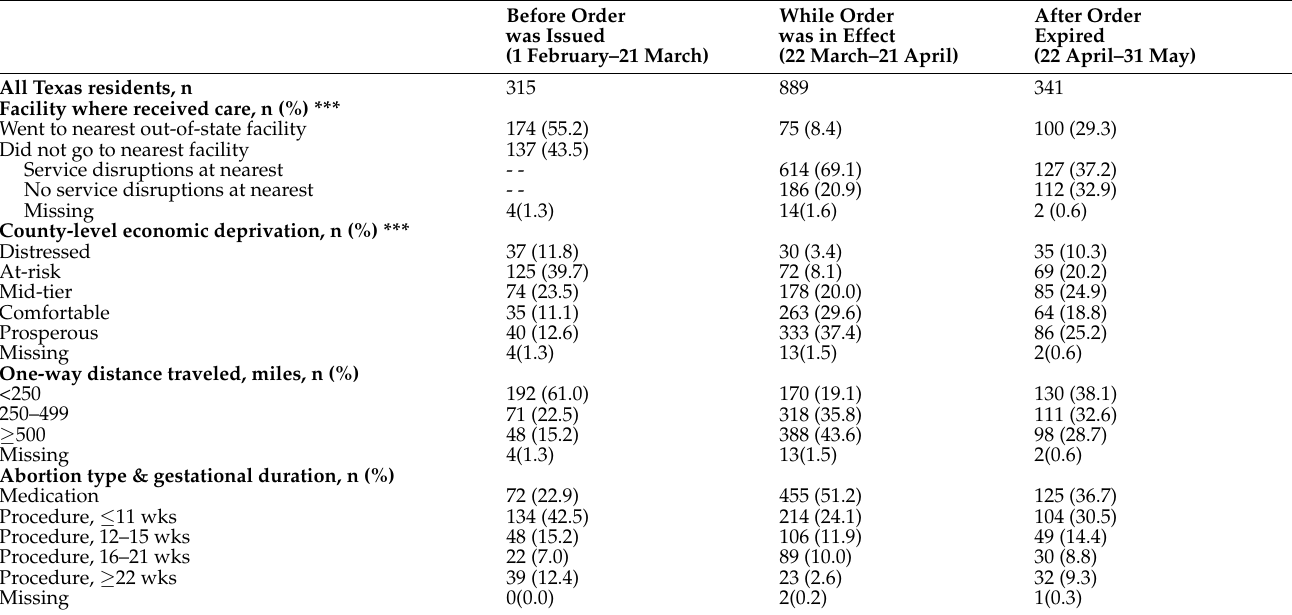
Table 1. Characteristics of where Texas residents obtained out-of-state abortion care and type of